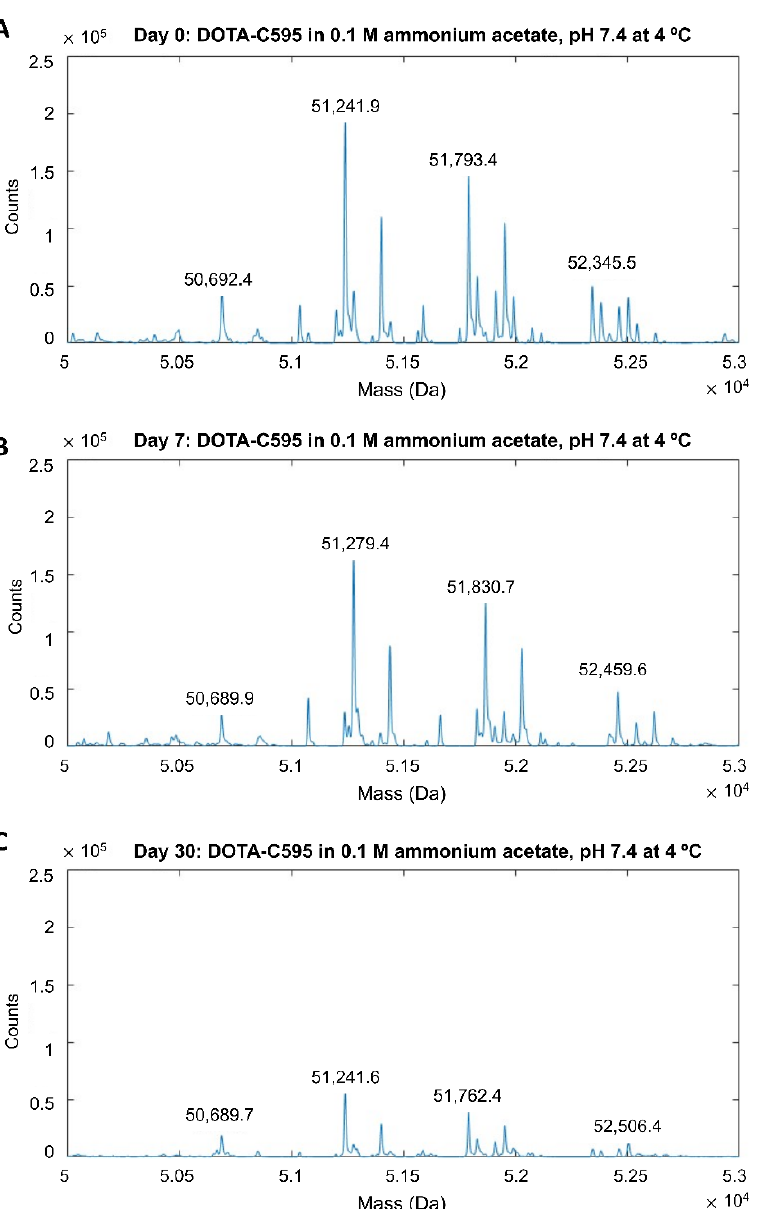
Figure 4. Mass spectra of heavy chain p-SCN-Bn-DOTA-C595 conjugate stored in 0.1 M ammonium acetate (pH 7.4) at 4 °C at ( A ) day 0, ( B ) day 7 and ( C ) day 30.